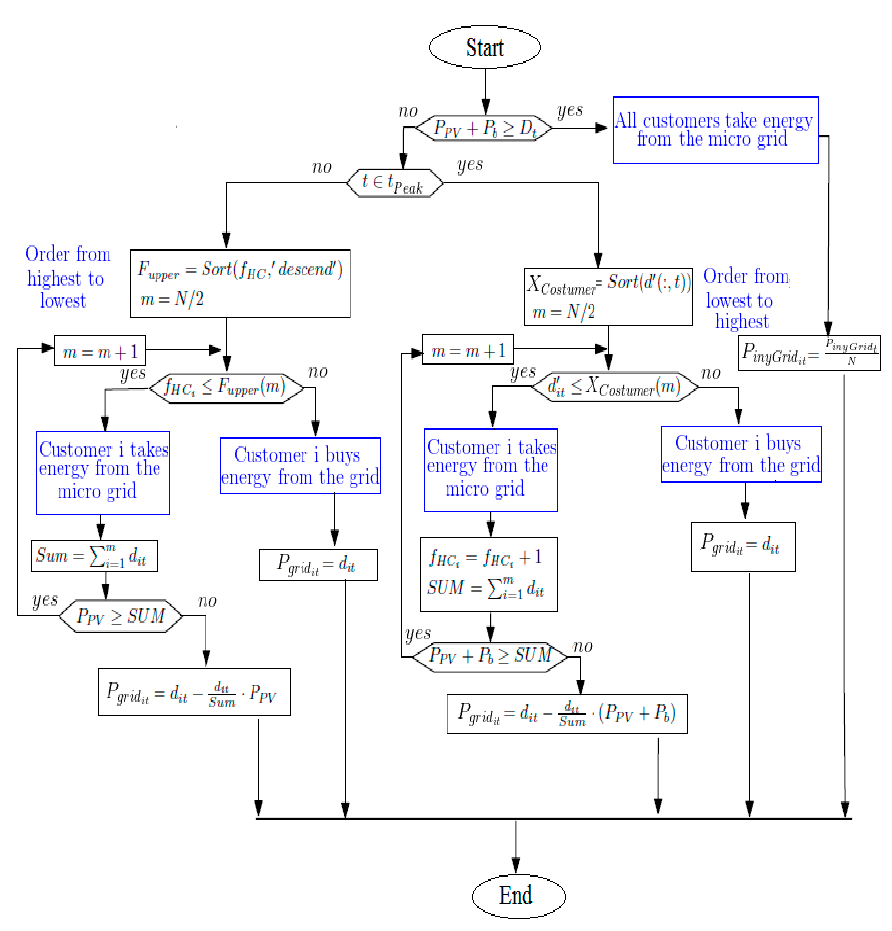
Figure 3. Flow chart to provide renewable energy to customers based on merit.